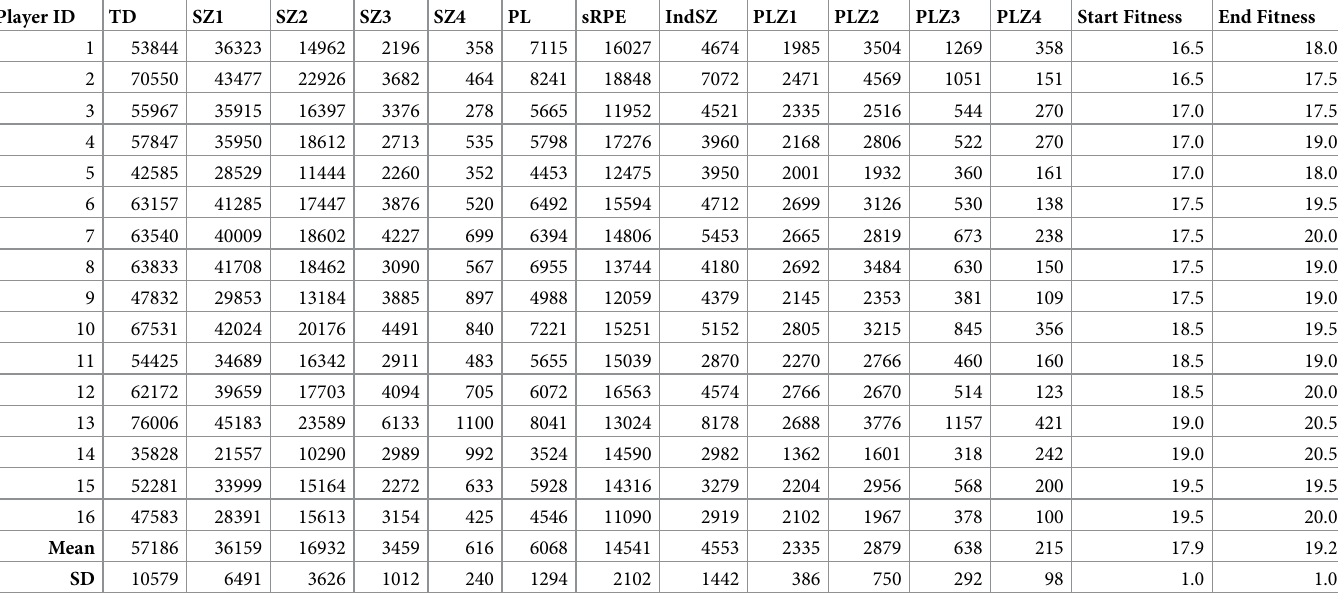
Table 2. Training load (TL) data and termination speed during 30–15 intermittent fitness test for 16 professional youth rugby league players. Player